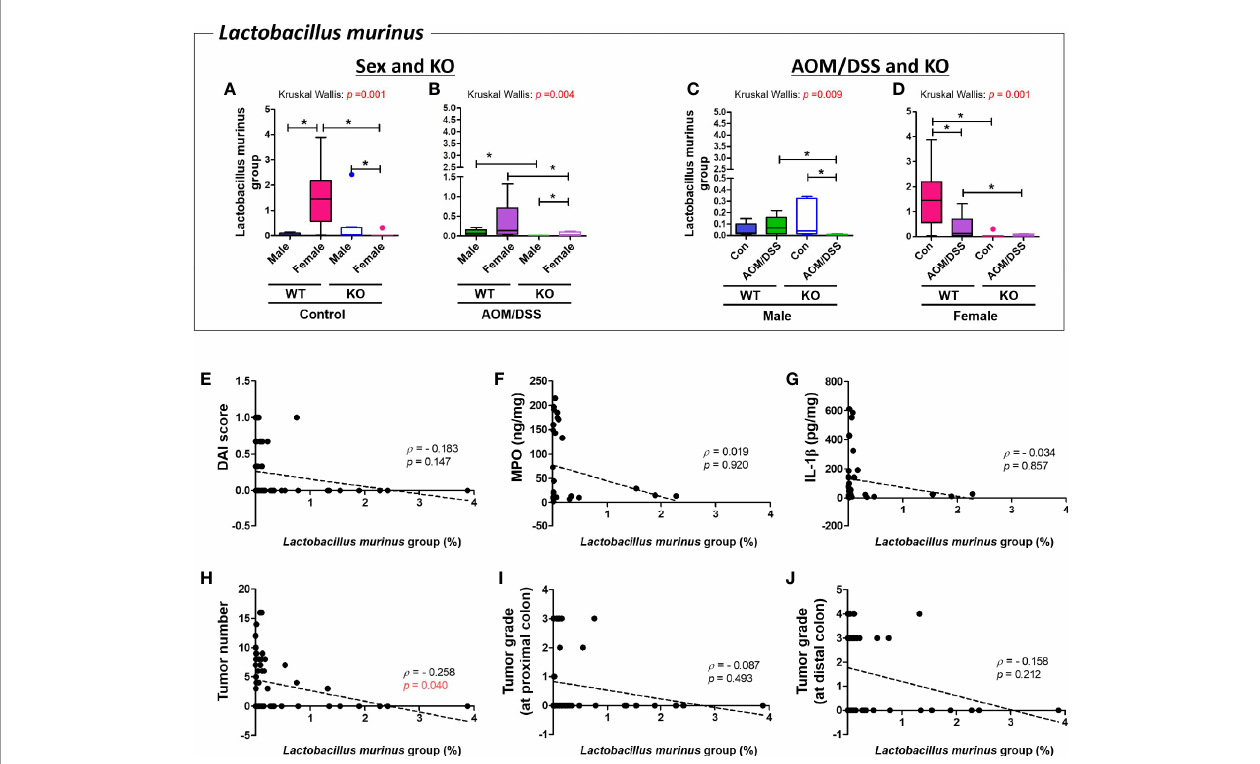
FIGURE 8 | Negative correlation between Lactobacillus murinus and tumor numbers in the colon. (A – D) Abundance (%) of Lactobacillus murinus in the groups with “ Sex and KO ” criteria (A, B) , as well as with “ AOM/DSS and KO ” criteria (C, D) . Data are expressed as the mean ± SEM. Whiskers show the minimum and maximum values. The p -values calculated using the Kruskal – Wallis test are shown in the fi gure; * p < 0.05, comparison between two groups (Mann – Whitney U-test). CRC, colorectal cancer; WT, wild-type; Nrf2 KO, Nrf2 knockout; Con, control; AOM, azoxymethane; DSS, dextran sodium sulfate. (E) DAI score, (F) MPO concentration, (G) IL-1 b concentration, (H) total tumor numbers, (I) grade of tumor arising from the proximal colon, and (J) grade of tumor arising from the distal colon. The abundance of Lactobacillus murinus was signi fi cantly correlated with total tumor numbers (H) . p < 0.05 (Spearman ’ s correlation test) (E – J) . Dotted line indicates the regression line. The correlations were analyzed using the Spearman ’ s rank correlation coef fi cient method (also known as Spearman ’ s rho) and linear regression. DAI, disease activity index; MPO, myeloperoxidase. Tumor grade: 0, no tumor; 1, low-grade adenoma; 2, high-grade adenoma; 3, mucosal invasive adenocarcinoma; 4, submucosal invasive